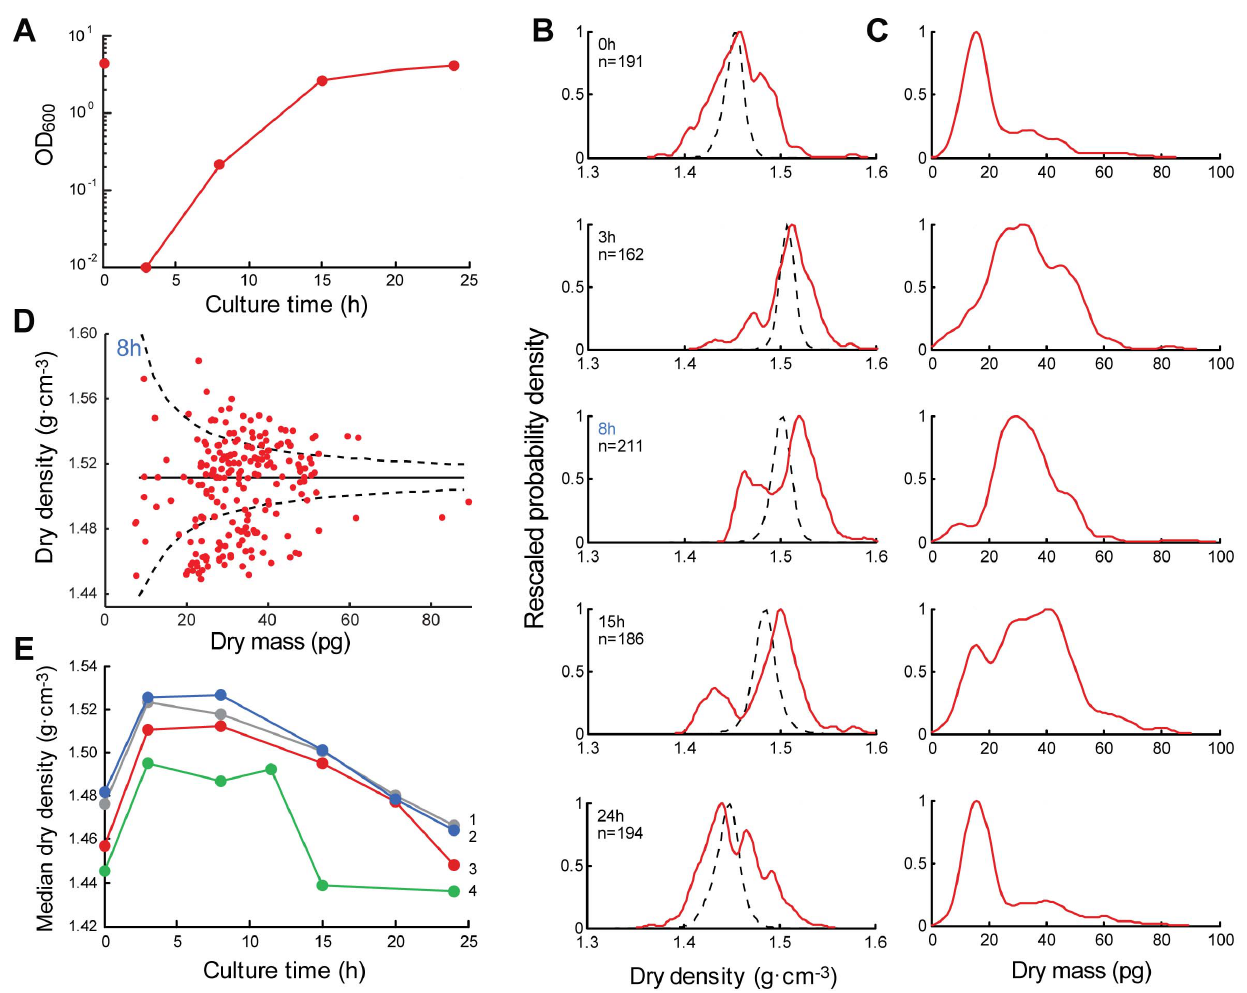
Figure 3. Dry density and dry mass of a yeast culture. a) Growth curve of a culture started from a 1000-fold dilution of a recently-saturated culture (time 0h). b) Distributions of dry densities for the time points indicated in a). Distributions expected due purely to measurement error (see text) are shown as black dashed lines. c) Dry mass distributions for the same time points. d) Single-cell data for time point 8h. Solid lines is median dry density and dashed lines are 99% bounds on the expected dry densities if all cells actually had the median dry density, given known measurement error (see Methods ). e) Dry density distribution medians for several replicates: curves 1 and 2 are technical replicates and 2–4 are biological replicates; curve 3 is for data show in